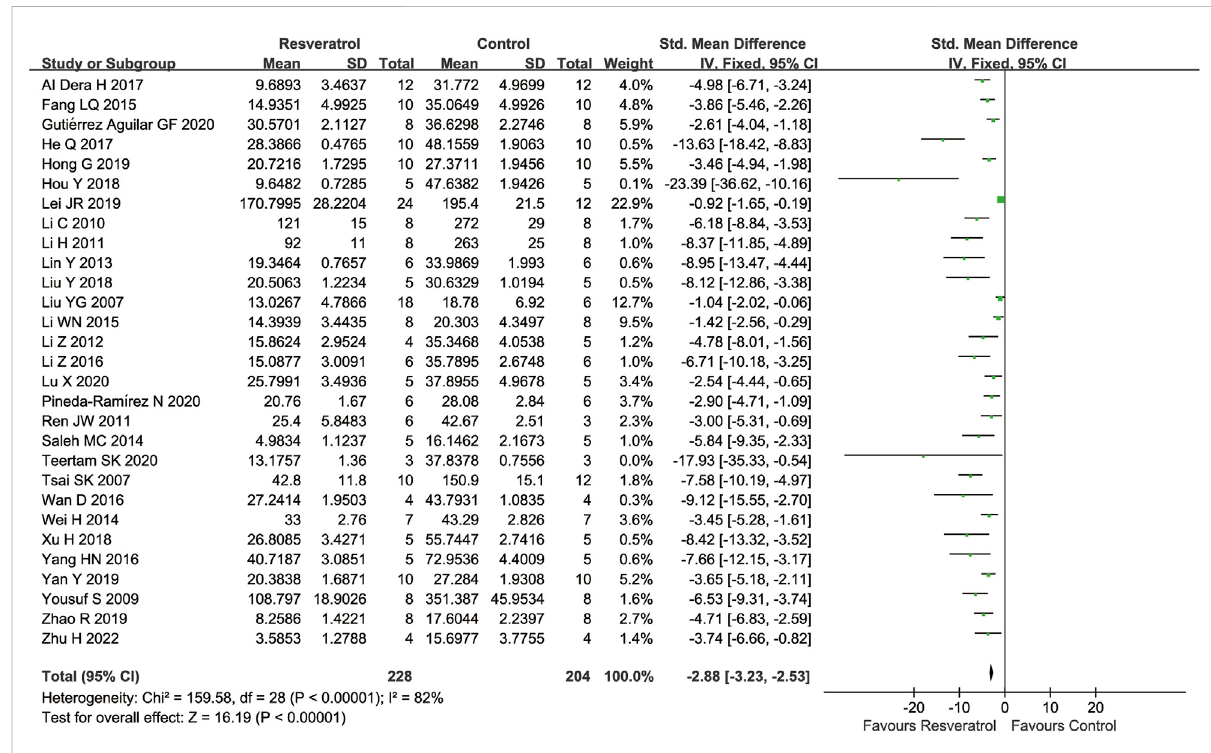
FIGURE 2 Meta-analysis of resveratrol for cerebral infarct volume in in rats after cerebral I/R